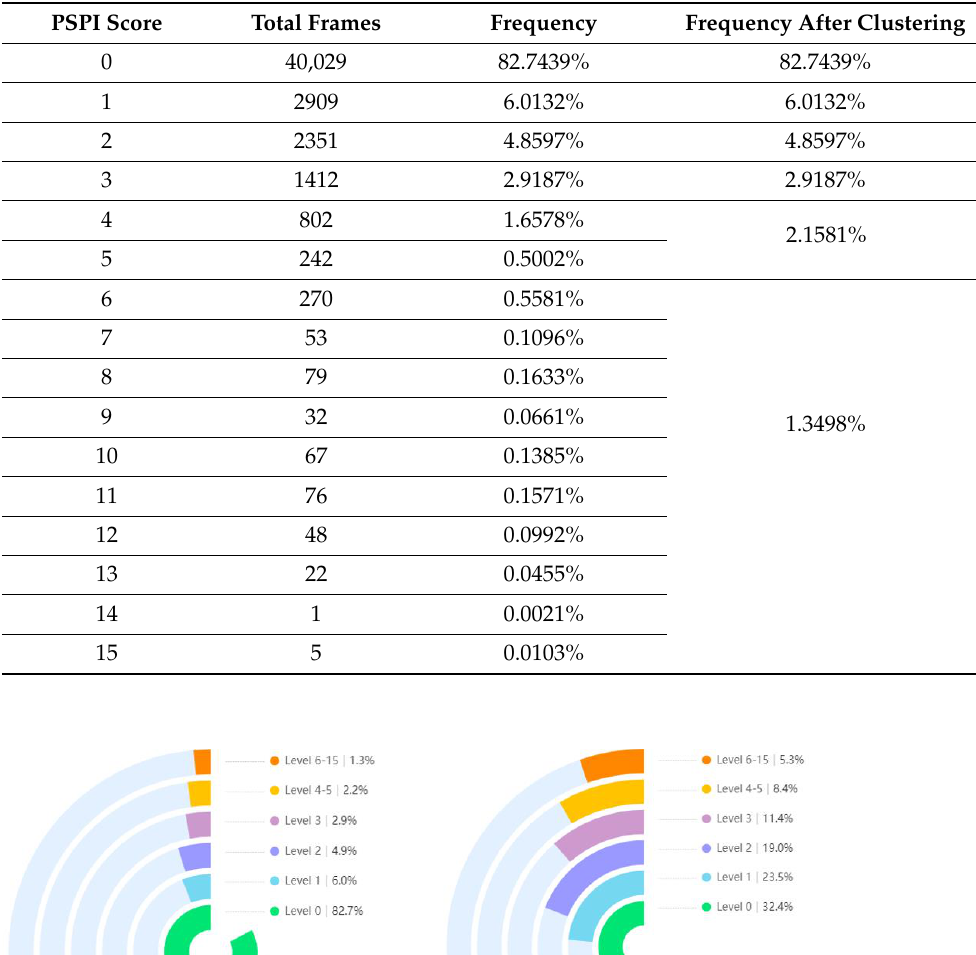
Table 1. The frequency of each pain intensity in the UNBC dataset according to the Prkachin–Solomon Pain Intensity (PSPI) pain metric.